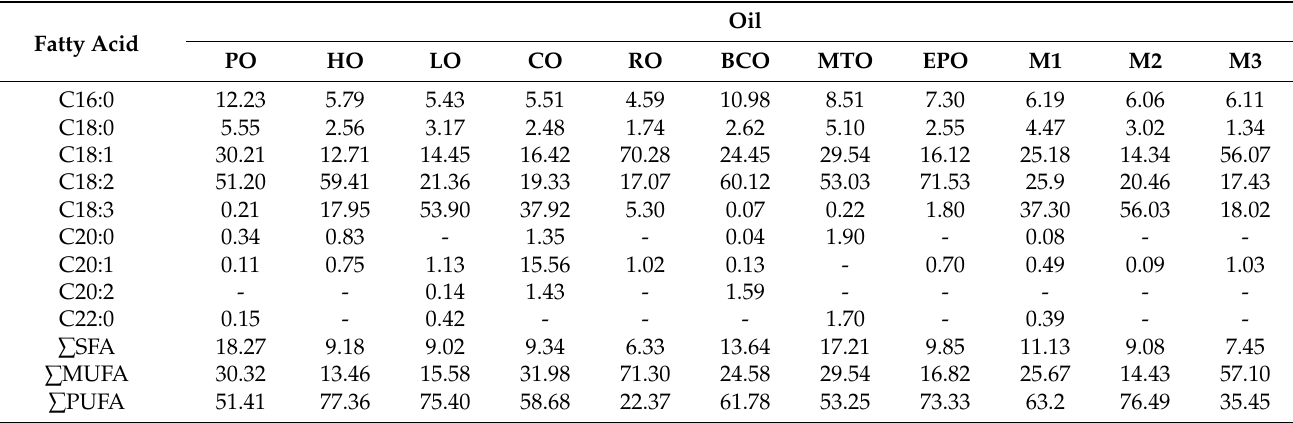
Table 2. Fatty acid composition of analysed